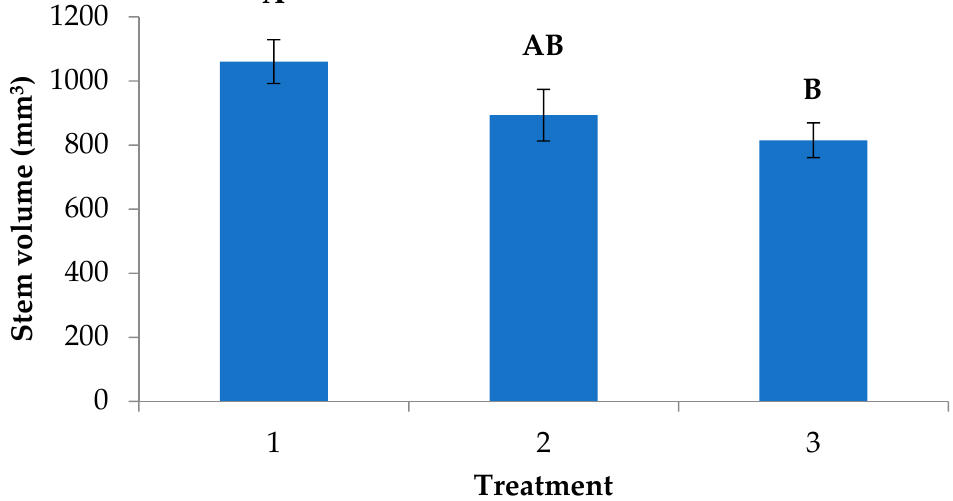
Figure 8. Mean stem volume (mm 3 ) (±SE) for five-year-old balsam poplar trees planted in 2019 (1 = 25 selected tolerant clones, 2 = 10 selected control clones, 3 = Stream 1 vegetative lot clones). Significant differences between treatment means for stem volume are indicated by different letters at p ≤ 0.05.